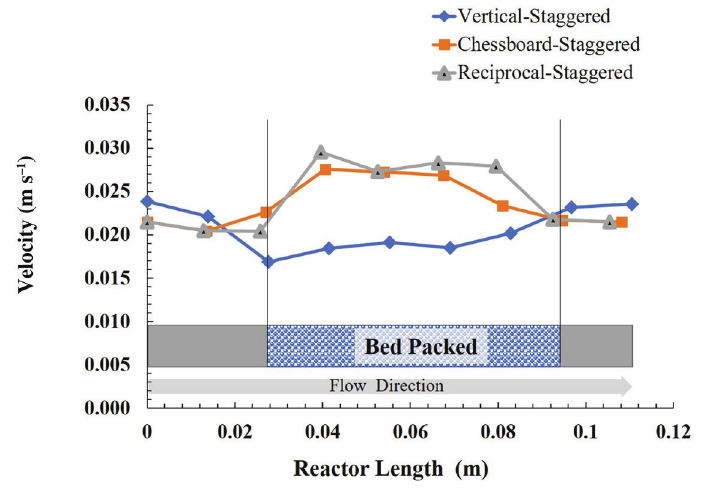
Fig. S6 – Velocity distribution profile for each packing pattern